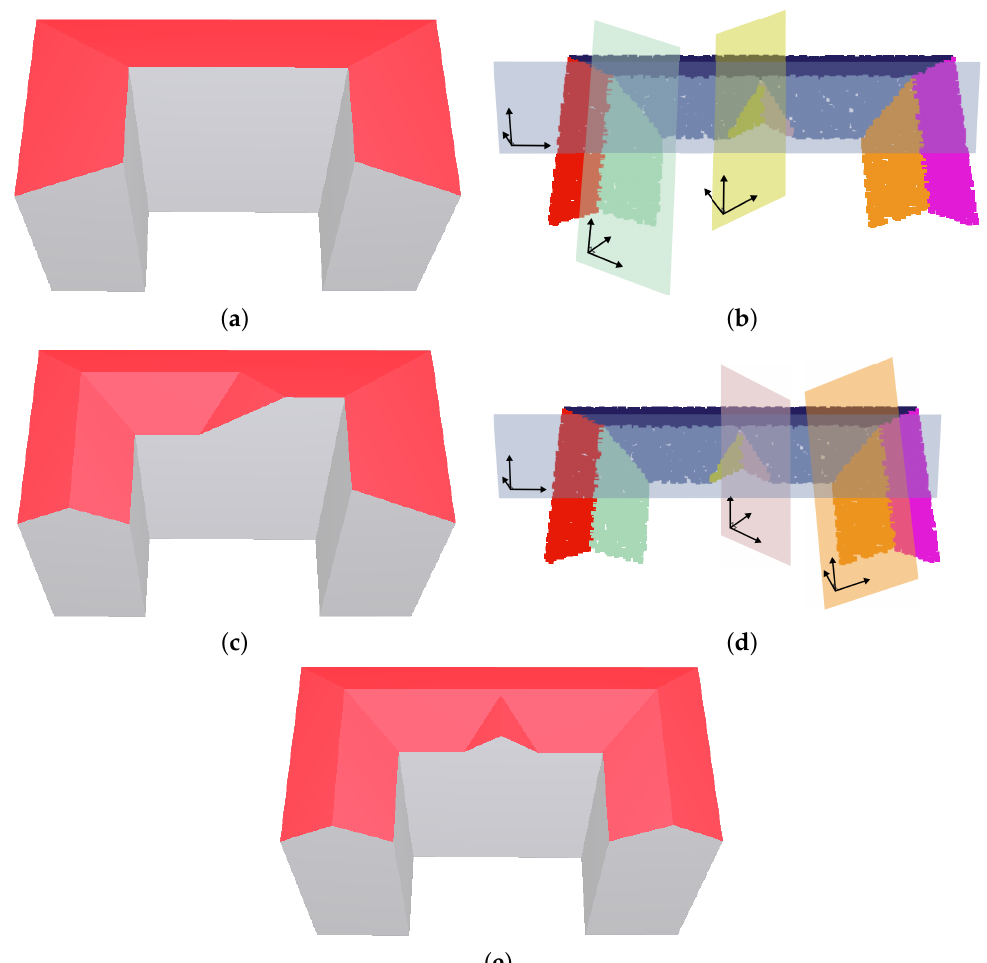
Figure 5. Illustration of shaping the model with obstructed half-spaces, where ( a ) shows the input model from the previous step, and ( b ) illustrates a slice that will be subtracted from the model. The slice is determined by three obstructed half-spaces that determine the smallest possible slice for one of the half-spaces. The result of the subtraction of the first slice is shown in ( c ). This is followed by the next slice ( d ), after which the final building model is obtained ( e